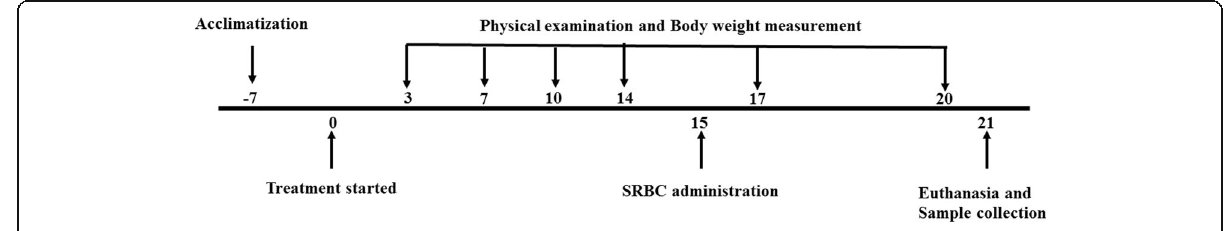
Fig. 1 Flow chart of the experimental